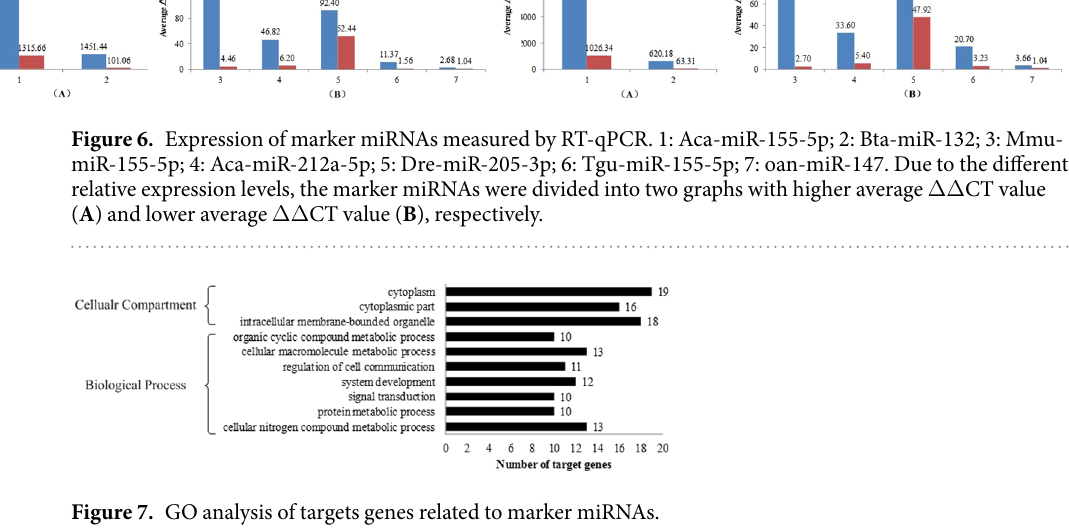
Figure 7. GO analysis of targets genes related to marker